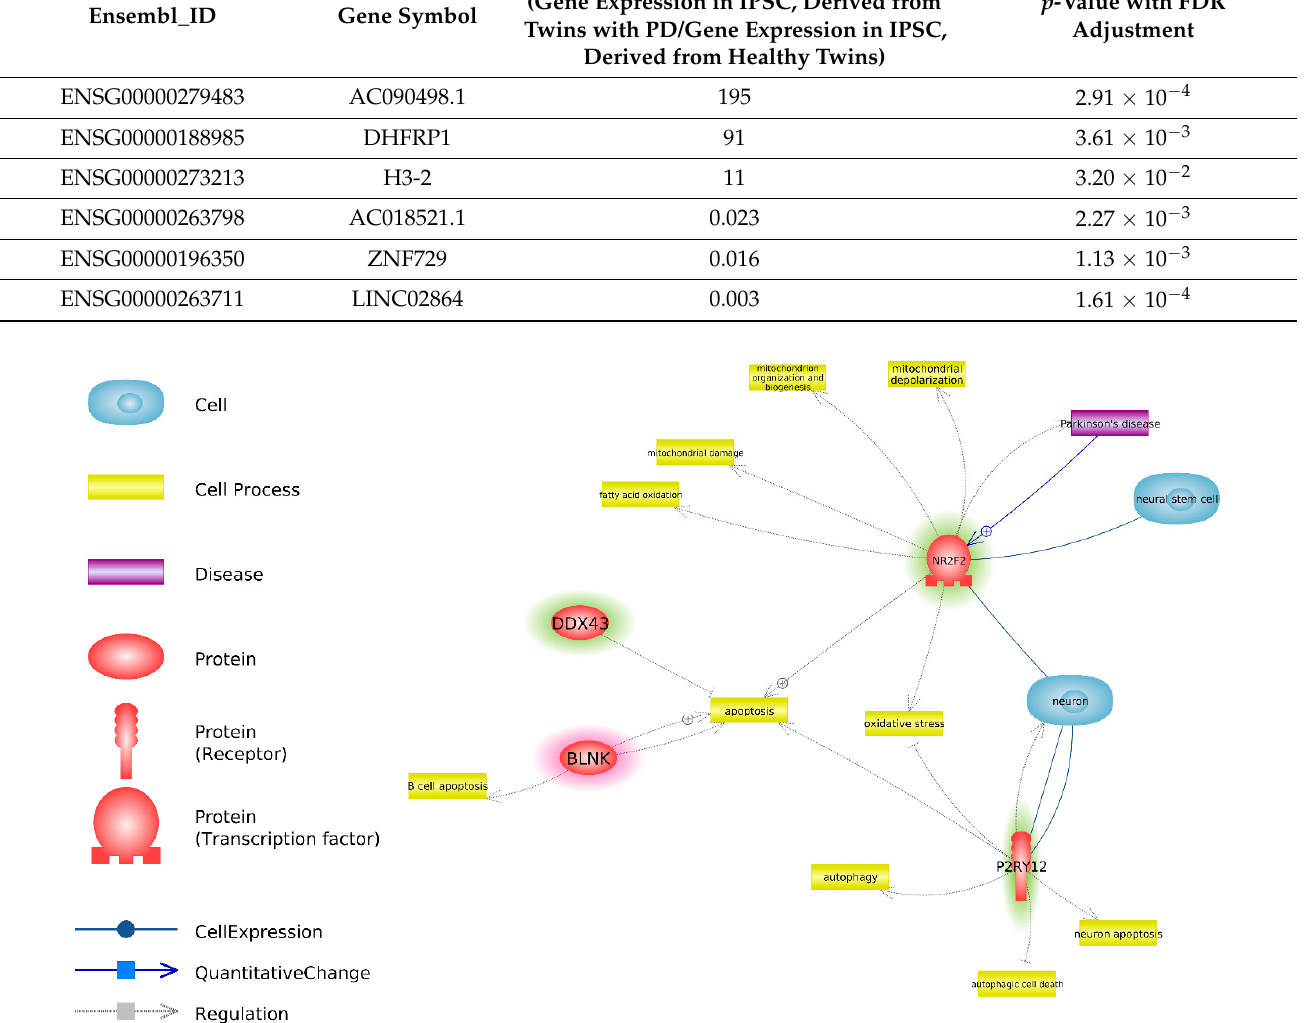
Figure 1. DEG IPSC interaction with neurons, neural stem cells, PD and biological processes, identified using key words “neurodegeneration”, “transport”, “vesicular”, “mitochondria”, “lysosome”, “oxidative stress”, “apoptosis” and “autophagy” according to Pathway Studio data. Genes, overexpressed in IPSC derived from twins with PD, as compared to IPSC derived from healthy twins are highlighted red. Genes, underexpressed in IPSC derived from twins with PD, as compared to IPSC derived from healthy twins are highlighted